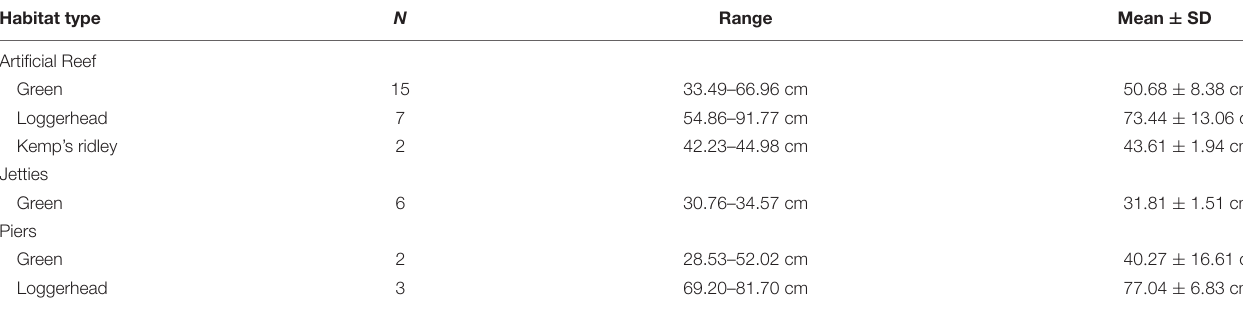
TABLE 2 | Straight carapace length ranges, with mean ± SD, of each species at each habitat type. Habitat type N